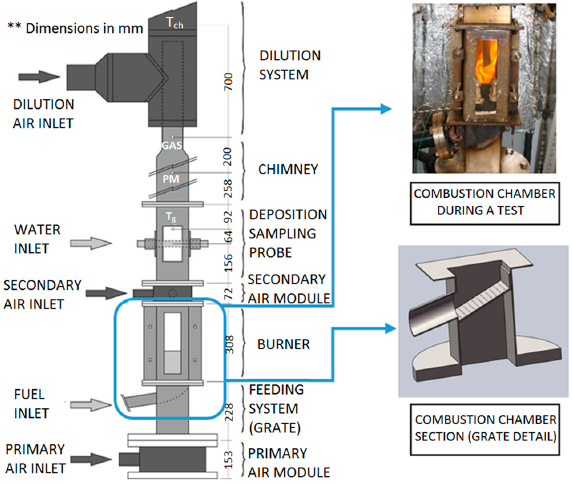
Figure 1. Scheme of the facility.